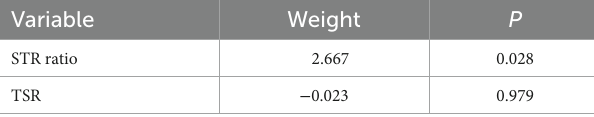
TABLE 4 Weights of STR ratio and TSR for calculating TME